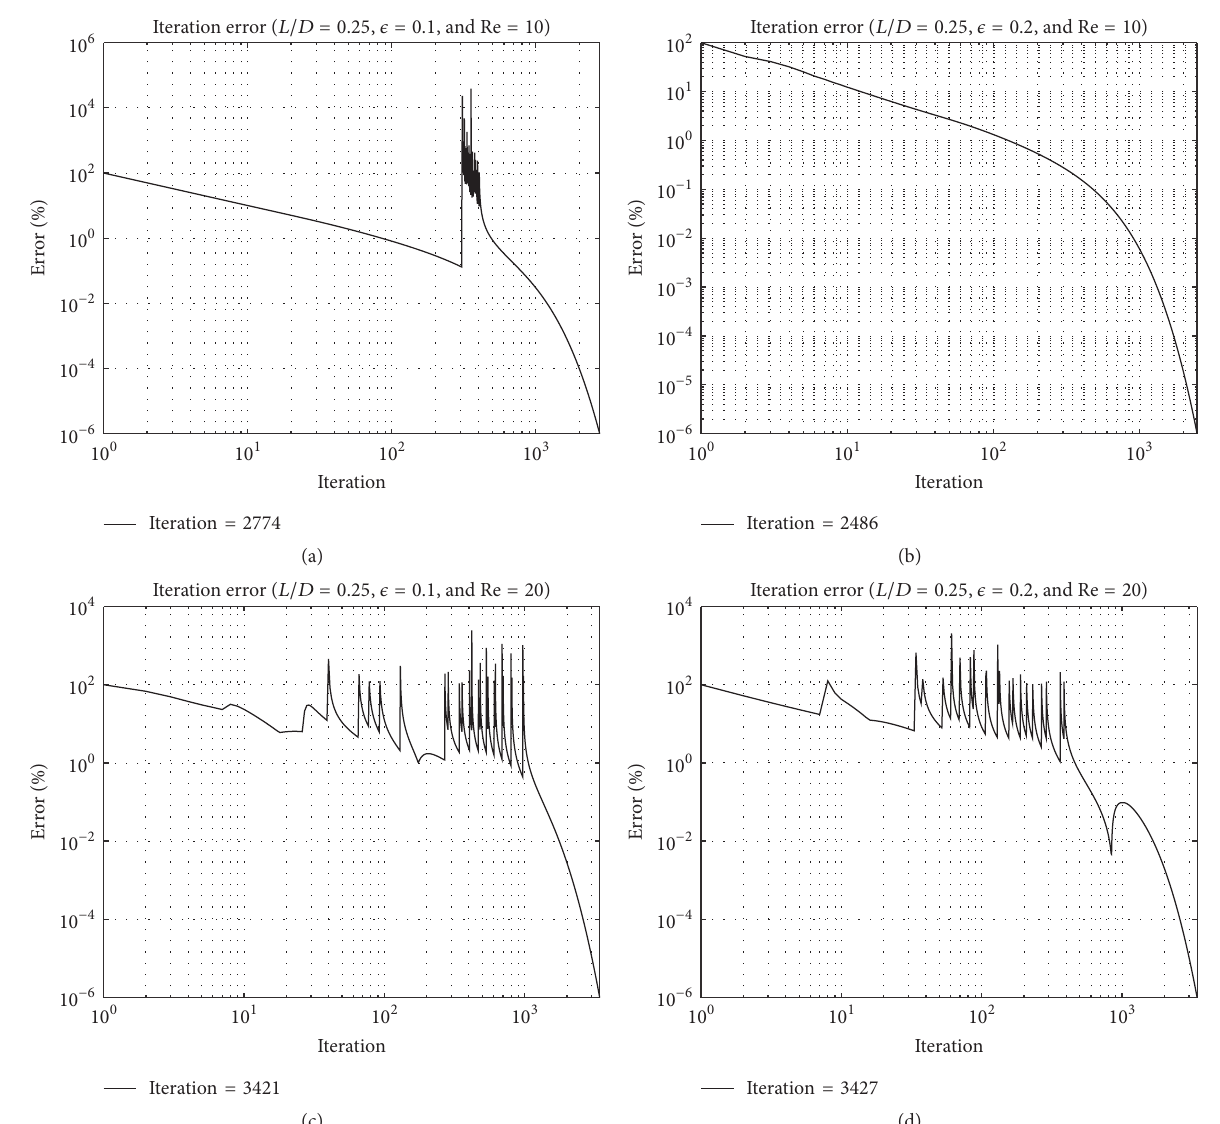
Figure 7: Evolution of the calculation error for several SFD operating